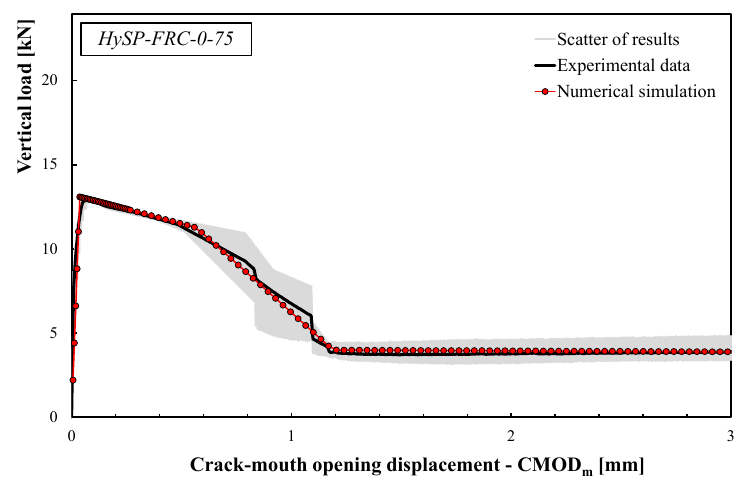
Figure 11. Experimental and numerical load–CMOD curves for the HySP-FRC-20-55 mixture.